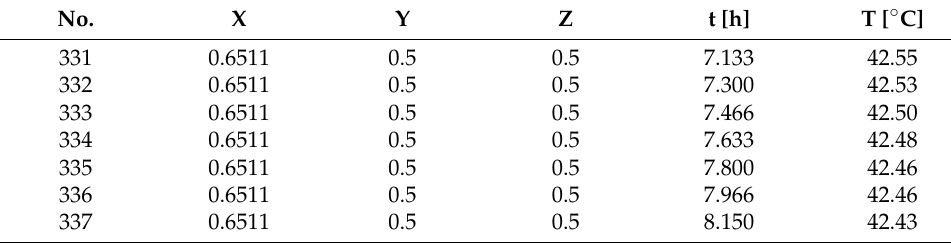
Table 2. A fragment of the training file for the ANN simulator (T—output